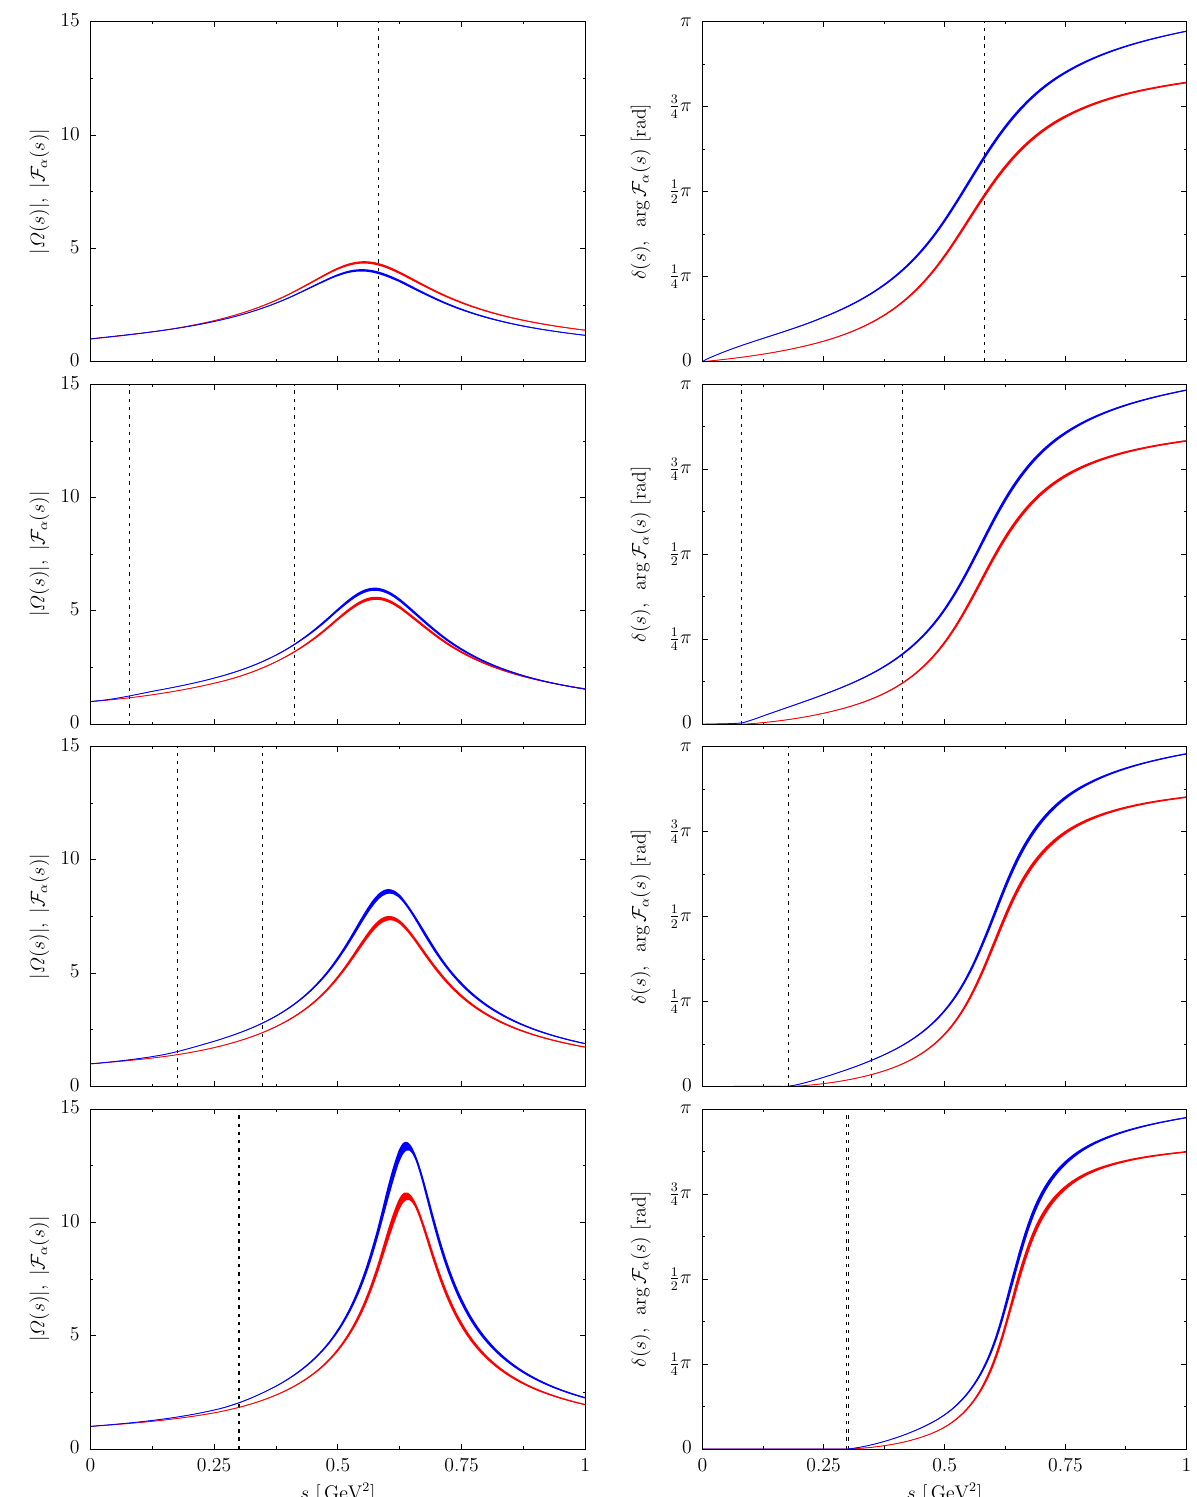
Fig. 4 Comparison of the absolute value (left column) and phase dependent lower and upper phase-space boundaries for the ω → 3 π motion (right column) of the Omnès function (red) and single-variable decay given by 4 M 2 π and ( M ω − M π ) 2 , respectively. The error bands are amplitude F α (blue) for various pion masses: first row M π = 0, sec- generated by taking the uncertainties of the IAM phase shift δ( s ) and ¯ M M ω ( M 2 π ) into account, see Fig. 2 and Eq. (38). The latter only affects ond row M π = ¯ M π , third row M π = 3 π , and last row M π = 2 F M ω ( M 2 π ) . The dashed black lines mark the pion-mass- 1 . 96 ¯ M π ≈ 1 3